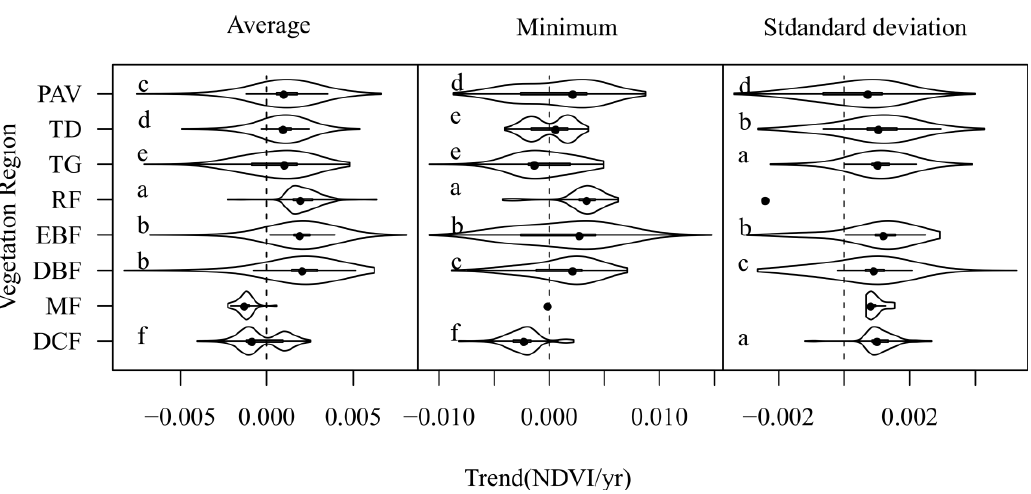
Figure 4. Violin plots of trends of annual average/minimum/standard deviation of NDVI at each pixel in each vegetation region. The black dots indicate the mean values; the short-segments indicate the interquartile range, as in standard box plots. Overlaid on them are kernel density estimations. Grouping results of Games-Howell post hoc pairwise comparison analyses are labeled with letters on the left. Regions with an insufficient number of pixels (<100) with significant trends were excluded from post hoc